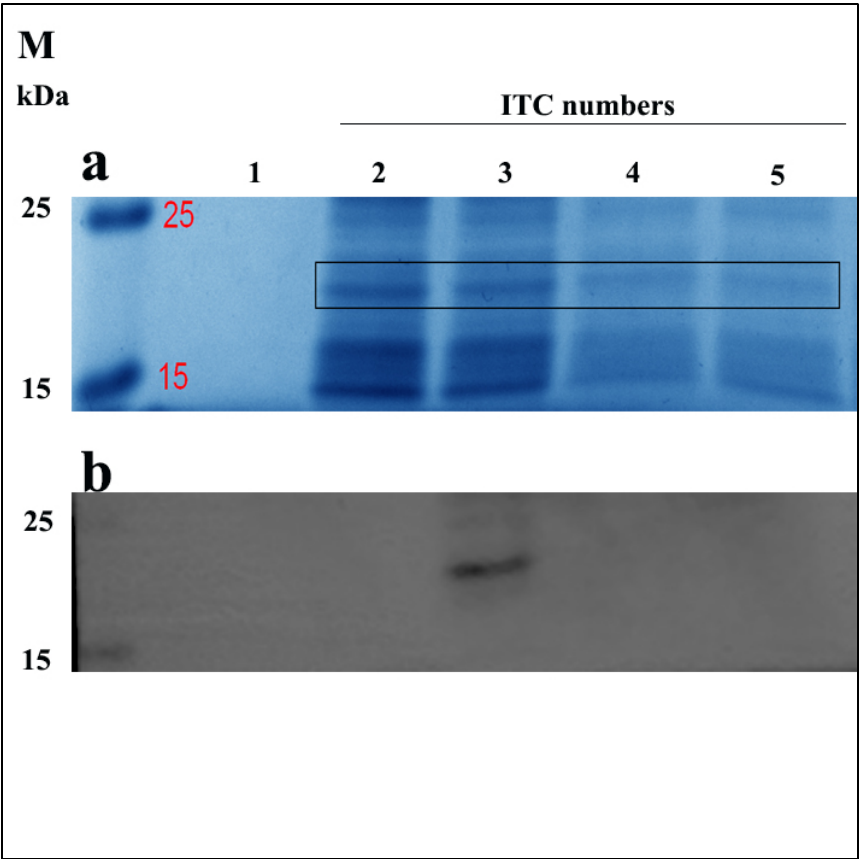
Figure 2. Expression of recombinant OEBD-1 in the E. coli Top10. Analysis of crude expression product in SDS-PAGE gel by Coomassie brilliant blue staining ( a ), and WB ( b ) with anti-6 × Gly-His. Purified OEBD-1 ( ∼ 19 kDa), the expressed OEBD-1 is indicated in gel by the filled black pane 1: pET-22b vector, 2: target protein was purified after once ITC, 3: target protein was purified after twice ITC, 4: target protein was purified after three times ITC, 5: target protein was purified after four times ITC, M: protein marker.